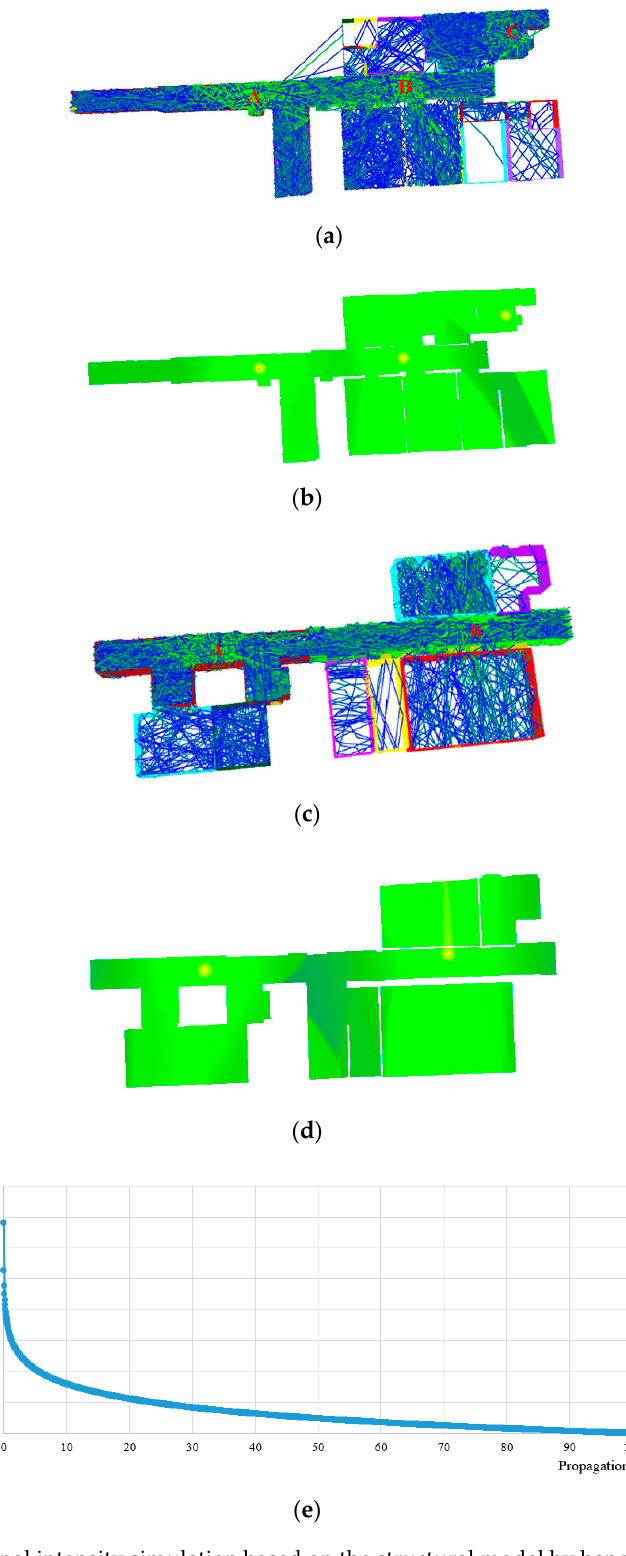
Figure 22. 5G signal intensity simulation based on the structural model by benchmark data. ( a ) The multipath signal propagation on the first floor. ( b ) Horizontal profile of signal intensity on the first floor. ( c ) The multipath signal propagation on the second floor. ( d ) Horizontal profile of signal intensity on the second floor. ( e ) Received energy value.